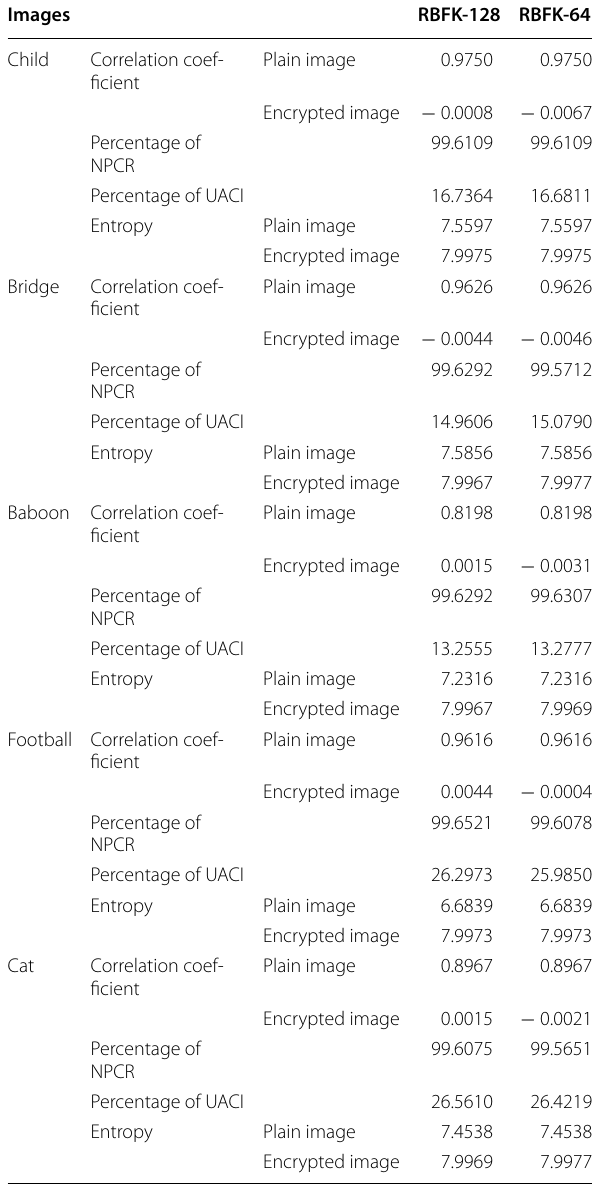
Table 6 NPCR, UACI, and correlation coefficients of RBFK ciphers Images RBFK‑128